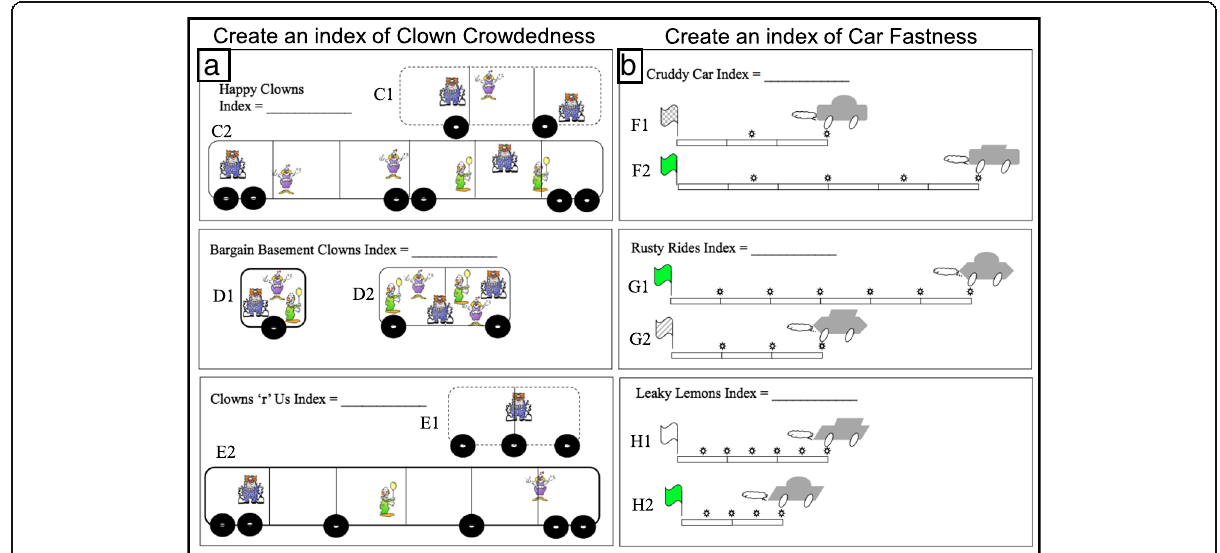
Fig. 2 Invention tasks, adapted from Schwartz et al. (2011). a Clown crowdedness. b Car